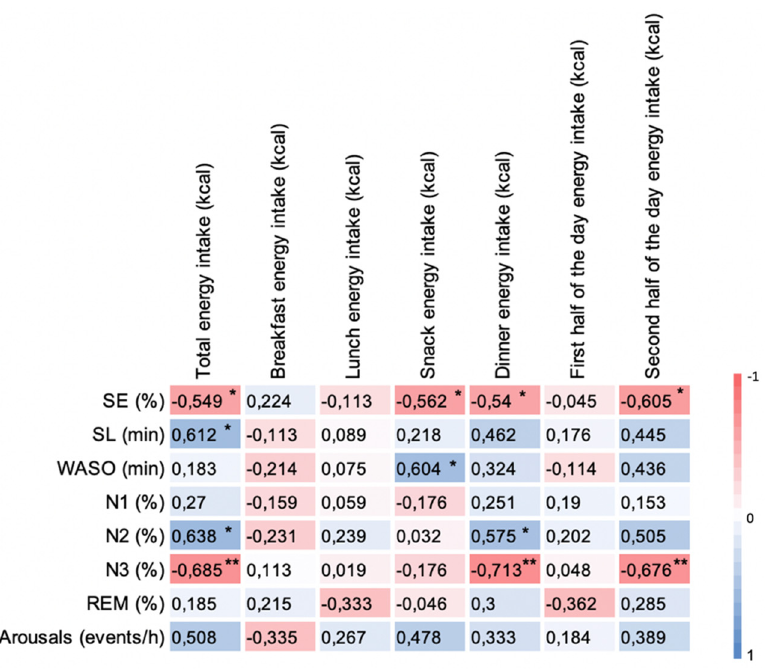
Figure 4. Heatmap representation of the correlations between Δ energy intake and Δ sleep outcomes between sessions (ad libitum—eucaloric) in OB group. Red indicates a negative relationship whereas blue indicates a positive relationship; the darker the color, the higher the Pearson coefficient; *: significant correlation with p < 0.05; **: significant correlation with p < 0.01.